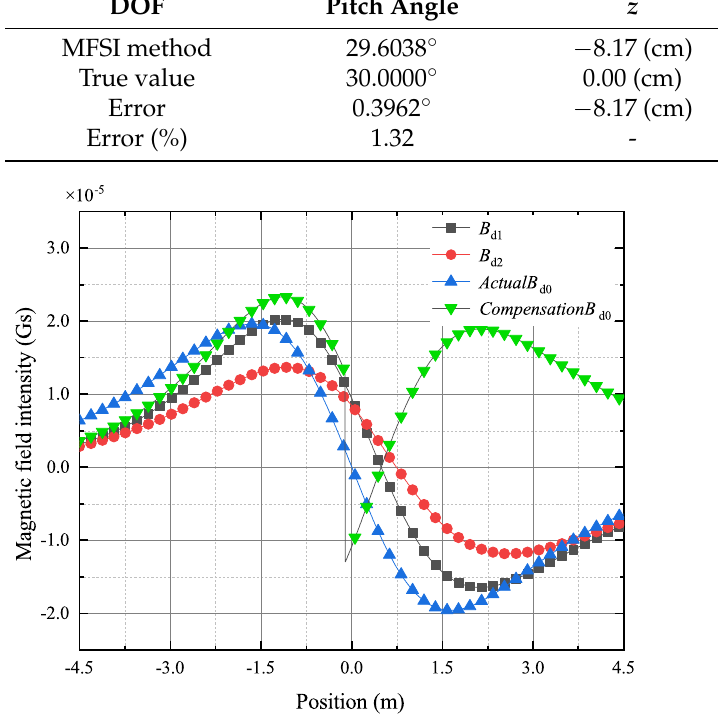
Figure 8. The radiated magnetic field of the transmitting coil in the pitch angle case. B d1 and B d2 are the measured magnetic field on the line ((0, 3, − 4.5), (0, 3, 4.5)) and line ((0, 3.5, − 4.5), (0, 3.5, 4.5)) in meters, respectively. CompensationB d0 is the compensated magnetic field by MFSI method, while ActualB d0 is y -axis component of the original magnetic field on the line ((0, 3, − 4.5), (0, 3, 4.5)) in